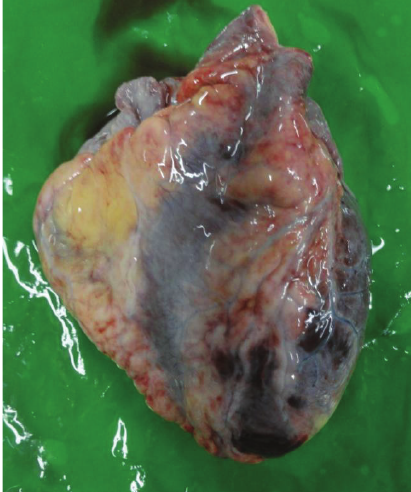
Figure1:Macroscopicappearanceoftheheartshowsmultipleflorid petechial to haemorrhagic